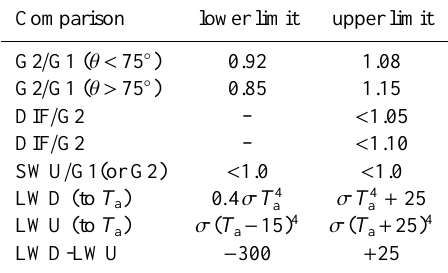
downwelling components of the IPY-BSRN dataset, and re-